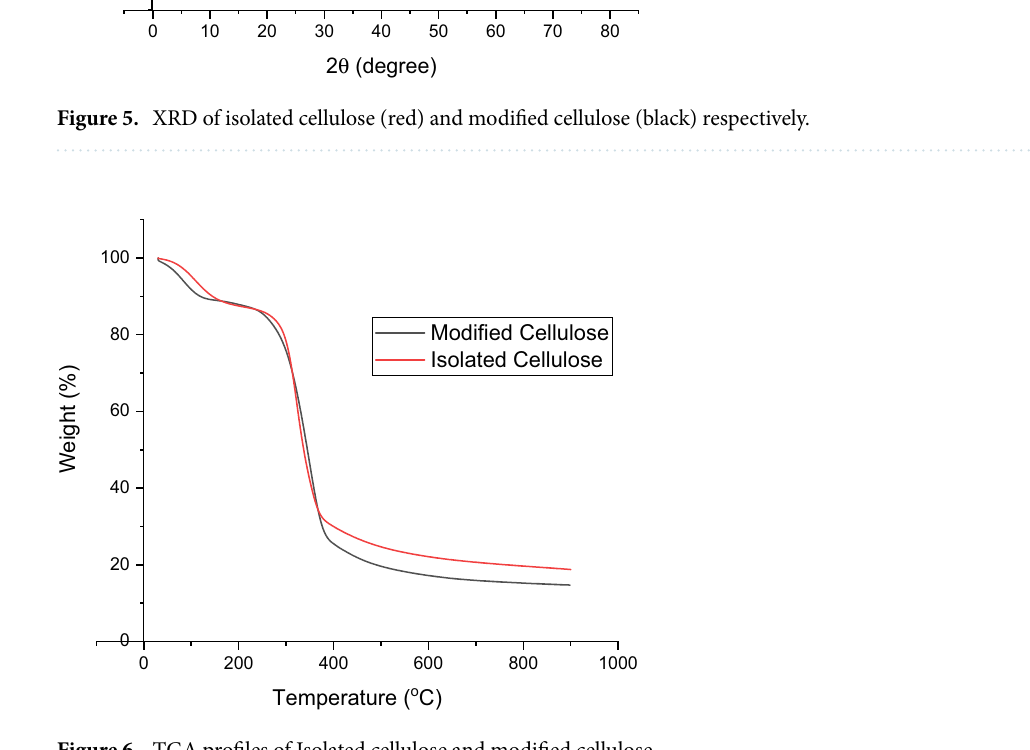
Figure 6. TGA profiles of Isolated cellulose and modified